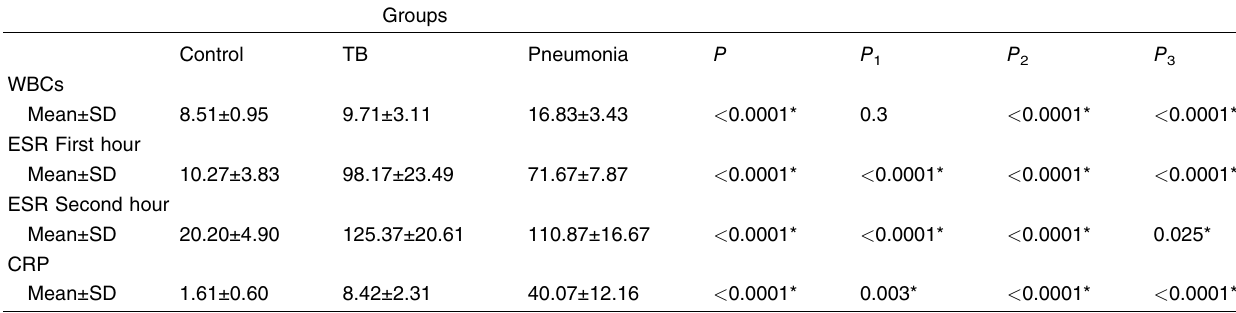
Table 2 Comparison among the three studied groups as regards some laboratory findings